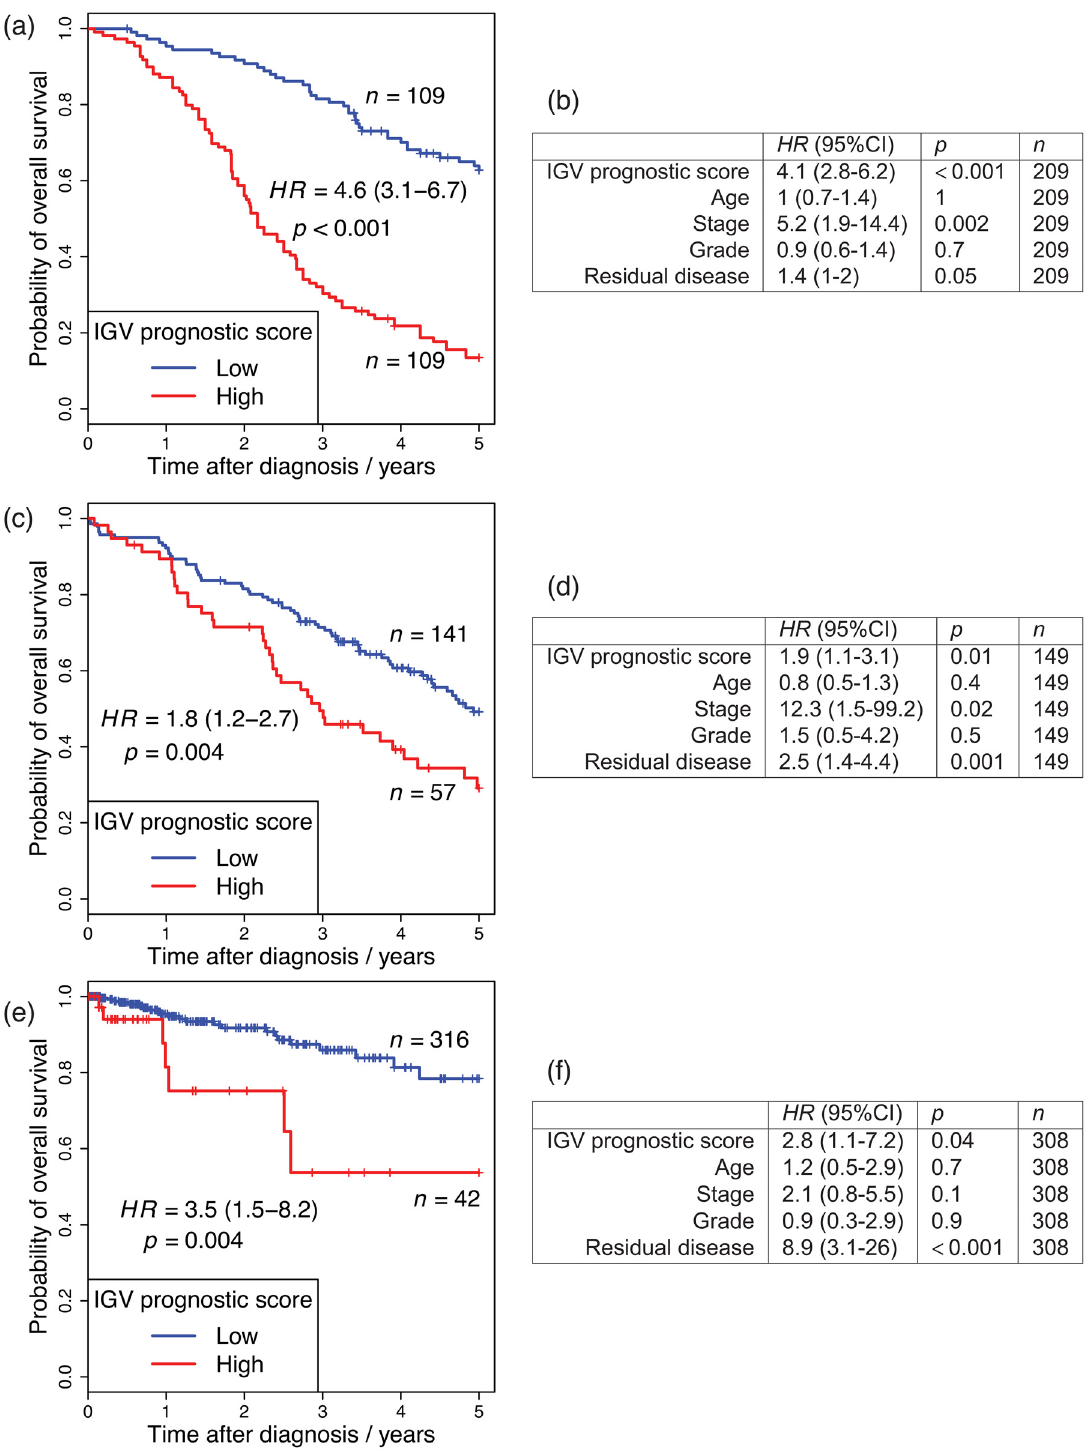
Fig 3. IGV OC prognostic signature validation. (a), (c) and (e): Comparison of survival curves of groups defined by the IGV prognostic score, in: (a) the main OC data set, (c) the Mayo Clinic OC validation set, (e) the uterine cancer TCGA validation set. The groups are divided by the median IGV prognostic score derived in the main OC DNAm data-set. The hazard ratio ( HR ) is displayed with 95% C.I. in brackets, with corresponding p -value calculated by univariate Cox regression. (d), (e) and (f): Multivariate Cox regression comparing the same groups defined by the IGV prognostic score.